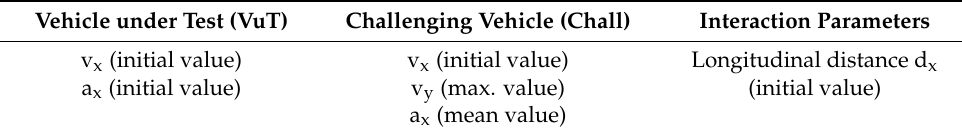
Figure 2. Cut-in scenario schematic (including relevant parameters considered). Table 1. Cut-in scenario parameters.